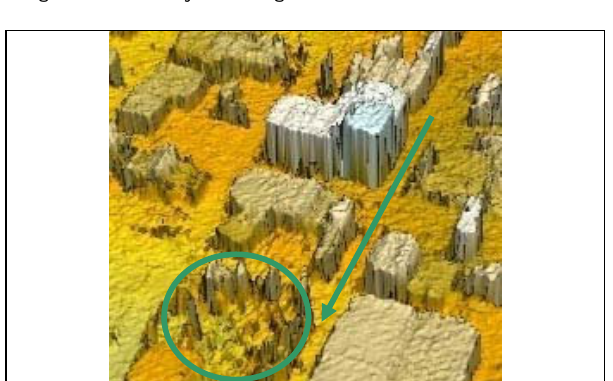
Figure 10: DSM by matching with DP with median filter